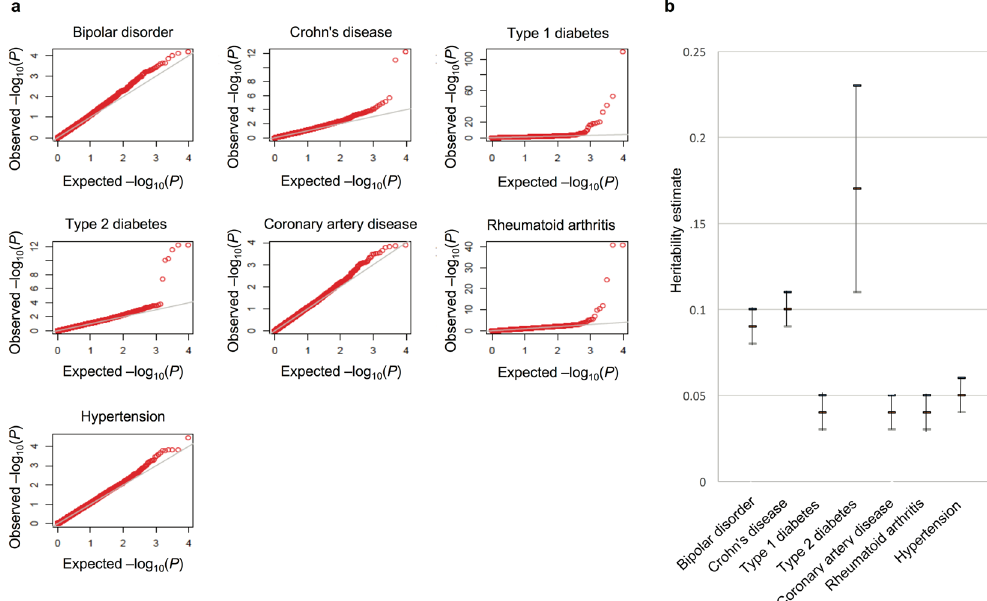
Figure 5. SRE SNPs and mapping disease-associated loci. ( a ) SRE SNPs were found among the top disease associations with the WTCCC disease traits. Several genome-wide significant (Bonferroni-adjusted p < 0.05) associations with disease traits were found to be SRE SNPs. The Q-Q plots show the distribution of SRE p-values for association with the disease phenotypes. ( b ) The contribution of the SRE SNPs to trait heritability varies with the trait, which may indicate the relative importance of splicing regulation to the genetic architecture. The estimate for the heritability and the corresponding standard error are